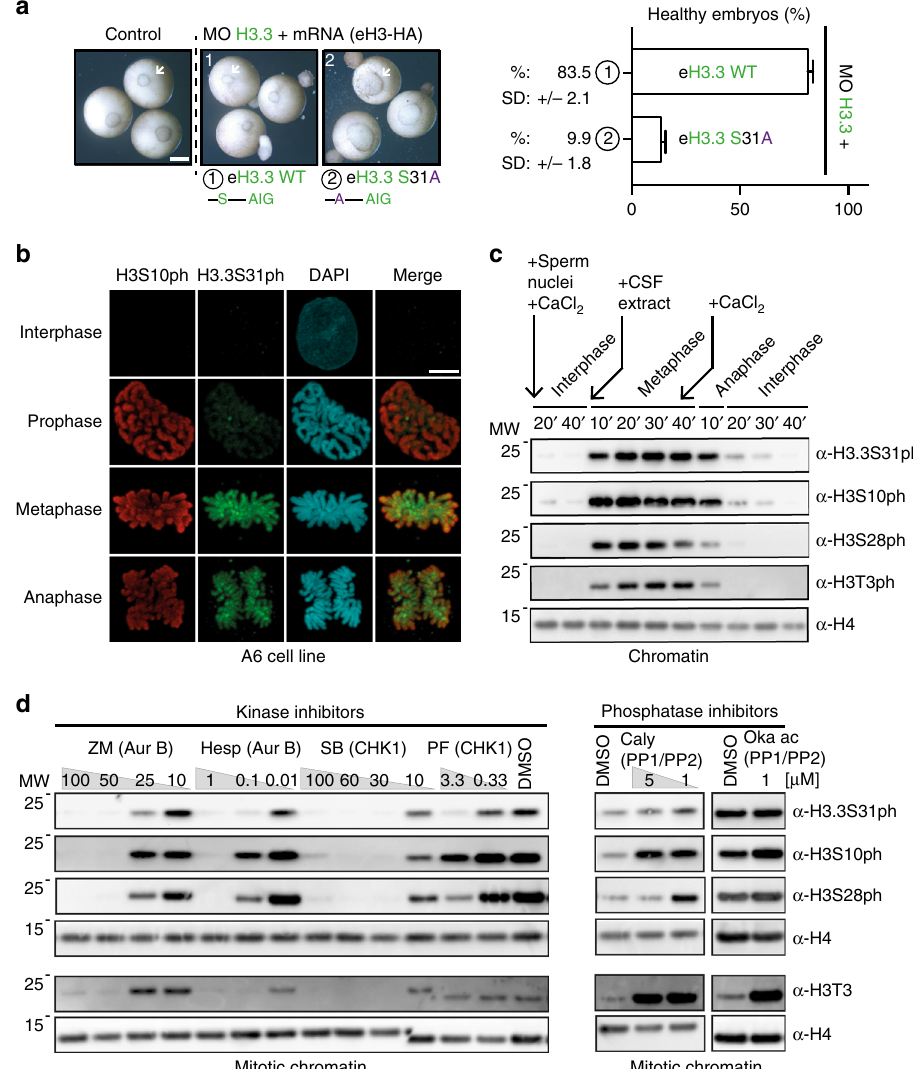
Fig. 4 In X. laevis , H3.3 S31 is critical for early development and is phosphorylated. a Rescue assays with eH3.3 S31A mutant. Injections are performed at two-cell stage. Effect on gastrulation is analyzed at stage 12. White arrowheads indicate the blastopore closure. Scale bar corresponds to 500 µ m. Bar plot shows mean ± SD for three independent experiments with more than 30 embryos. b Representative immuno fl uorescence images showing 3D-distribution and timing of H3.3S31 and H3S10 phosphorylation in the Xenopus A6 cell line. Scale bar represents 10 µ m. c H3.3 S31ph dynamics in Xenopus egg extracts. Nuclei remodeled in extracts cycled to interphase, mitosis, and then to the second interphase are puri fi ed at the indicated time. Kinetics (appearance and removal) of the H3 phosphorylation is analyzed by western blotting with indicated antibodies. H4 is used as a loading control. Primary antibodies indicated on the right. Molecular weight (MW) markers in kDa indicated on the left. d Effects of kinase and phosphatase inhibitors on H3 phosphorylation in mitotic egg extracts. Puri fi ed nuclei remodeled in the CSF-arrested extracts supplemented with indicated inhibitors are analyzed by western blotting with indicated antibodies. H4 is used as a loading control. Primary antibodies indicated on the right. Molecular weight (MW) markers in kDa indicated on the left. Source data are provided as a Source Data fi